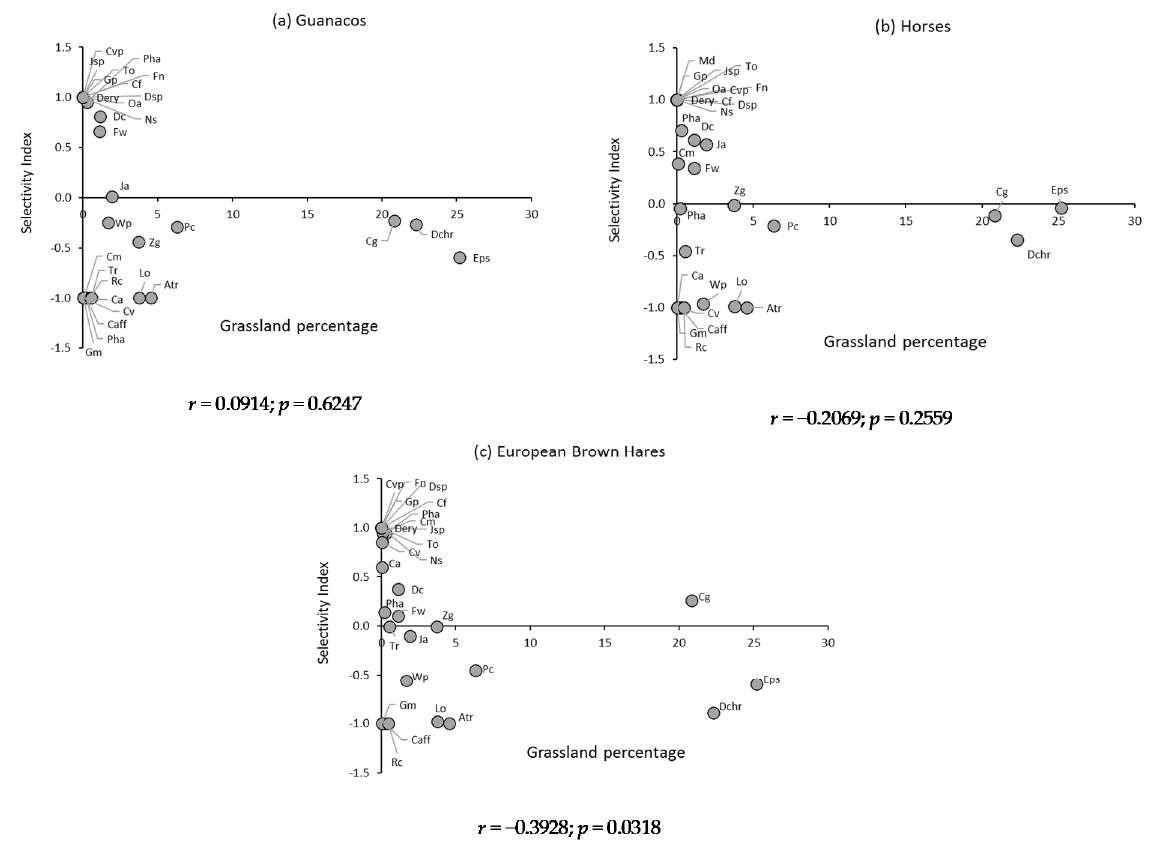
Figure 5. Ivlev’s selectivity index for the main plant species of ( a ) guanacos, ( b ) horses, and ( c ) European brown hare’s diets, in hydromorphic grasslands. Average values of two summer evaluation seasons. Deschampsia caespitosa (Dc) , Deyeuxia chrysostachya (Dchr) , D. erythrostachya (Dery) , D. (Dsp) , Festuca werdermannii (Fw) , F. nardifolia (Fn) , Nicoraepoa subenervis (Ns) , Phleum alpinum (Pha) , Trisetum oreophilumv(To) , Carex gayana (Cg) , C. maritima (Cm) , C. vallis-pulchrae (Cvp) , Eleocharis pseudoalbibracteata (Eps) , Juncus arcticus (Ja) , J. (Jsp) , Oxychloe andina (Oa) , Phylloscirpus acaulis (Pha) , Patosia clandestine (Pc) , Zameioscirpus gaimardioides (Zg) , Azorella trifoliolata (Atr) , Calandrinia affinis (Caff) , Calceolaria filicaulis luxurians (Cf) , Cardamine vulgaris (Cv) , Cerastium arvense (Ca) , Gayophytum micranthum (Gm) , Gentiana prostrata (Gp) , Lobelia oligophylla (Lo) , Mimulus depressus (Md) , Ranunculus cymbalaria (Rc) , Trifolium repens (Tr) , Werneria pygmaea (Wp).